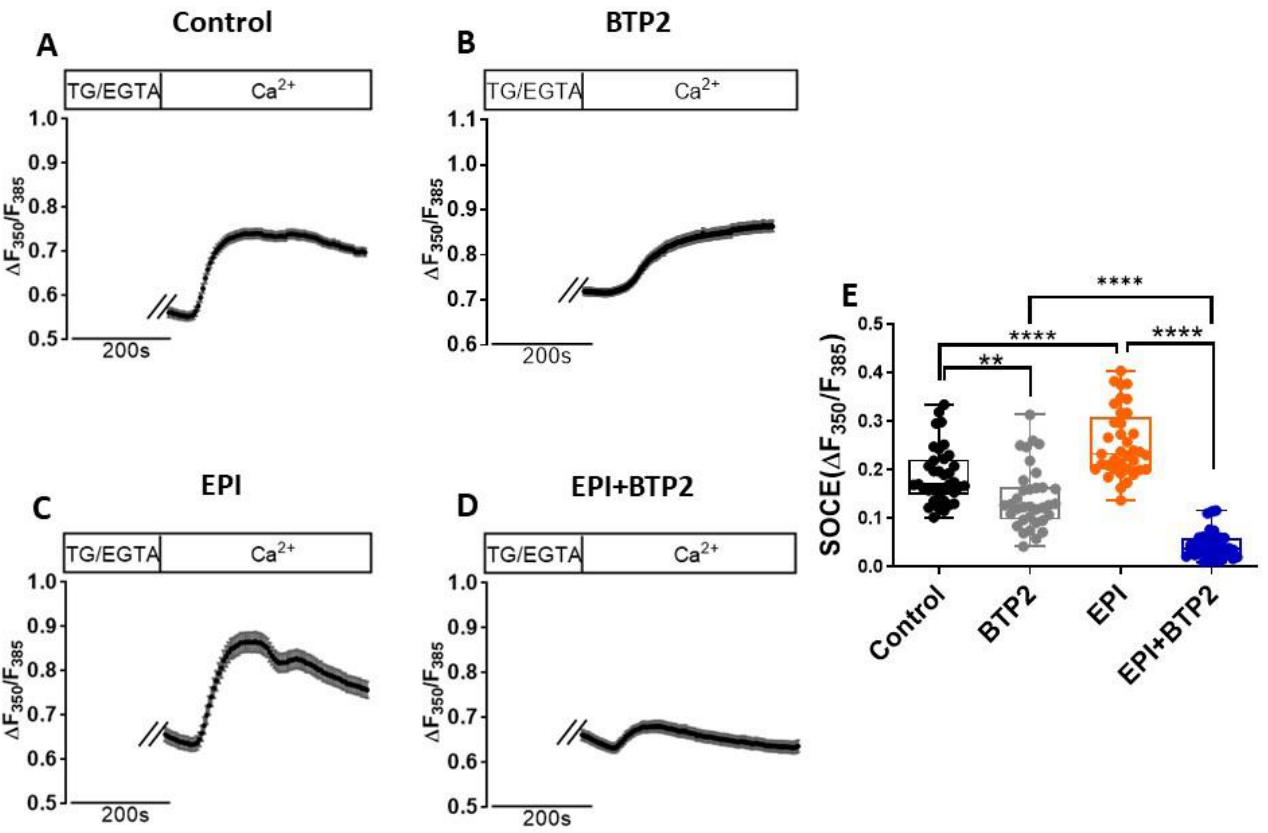
Figure 2. Acute treatment of EPI increased SOCE in HL-1 cardiomyocytes. Ratio of fluorescence of fura-2 AM at two excitation wavelengths (F350 nm/F385 nm) was used to monitor changes in intracellular Ca 2+ concentration. ( A – D ) Representative traces of intracellular Ca 2+ in HL-1 cells treated with vehicle control, 20 µ M BTP2, 1 µ M EPI, or 20 µ M BTP2 plus 1 µ M EPI for 30 min. ( E ) Statistical analysis of SOCE in HL-1 cells. Mean ± SD, n = 35. **: p = 0.0056, ****: p < 0.0001 (based on one-way